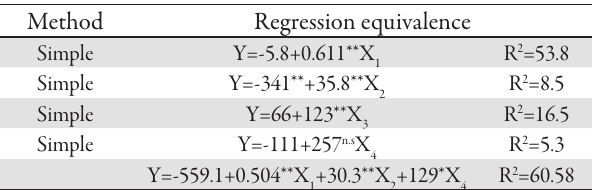
Tab. 7. Simple regression equivalences of seed yield with Alfalfa seed yield components of Mesasirsa separately